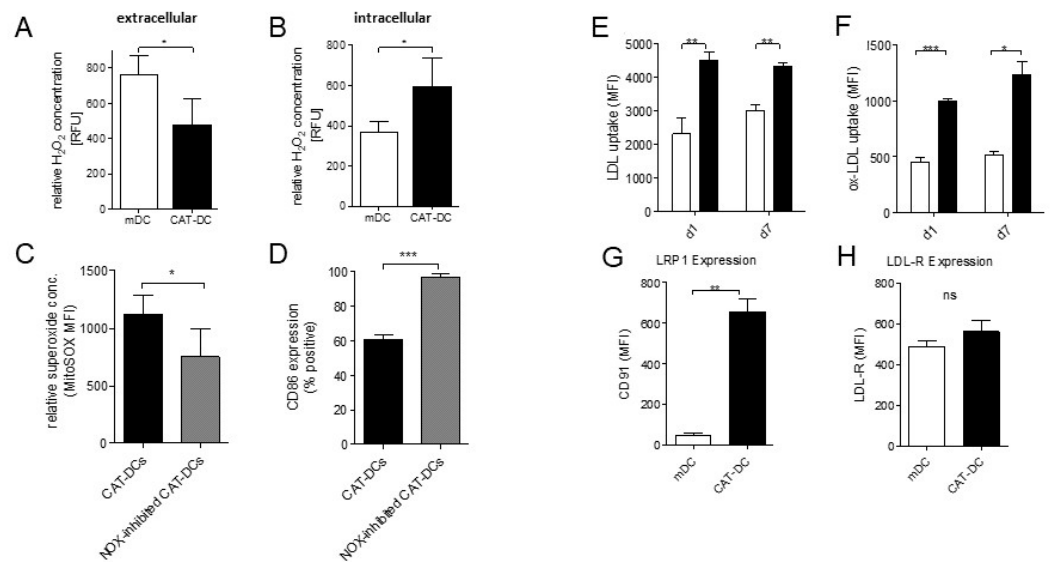
Figure 5. Extracellular H 2 O 2 depletion by catalase leads to increased intracellular H 2 O 2 levels and increased LDL/oxLDL uptake with increased expression of the LDL-uptake-receptor LRP-1. ( A ) Measurement of relative extracellular H 2 O 2 levels of CAT-DCs by fluorometric detection using the Amplex RED assay in comparison to mDCs ( n = 5). ( B ) Comparison of intracellular H 2 O 2 levels visualized by CellRox Ultra Red between CAT-DCs and mDCs using flow cytometry (RFU = relative fluorescent units; representative plot: Figure S7E). ( C ) Analysis of superoxide concentration following NADPH oxidase (NOX) inhibition in CAT-DCs as compared to untreated CAT-DCs ( n = 5). ( D ) Analysis of CD86-expression on CAT-DCs following NOX-inhibition in comparison to untreated CAT-DCs ( n = 5). ( E , F ) Measurement of relative ox-/LDL uptake by fluorometric detection of phRodo-LDL and dil-oxLDL in CAT-DCs as compared to mDCs at d1 and d7 ( n = 5, representative plots: Suppl. Data VIII A and B). ( G , H ) Flow-cytometric detection of LDL-R and LRP1 expression as determined by MFI on mDCs and CAT-DCs ( n = 3; representative plot: Figure S7C,D). Statistical analysis was performed with a paired two-tail Student’s t -test. (* p < 0.05, ** p < 0.01, *** p <